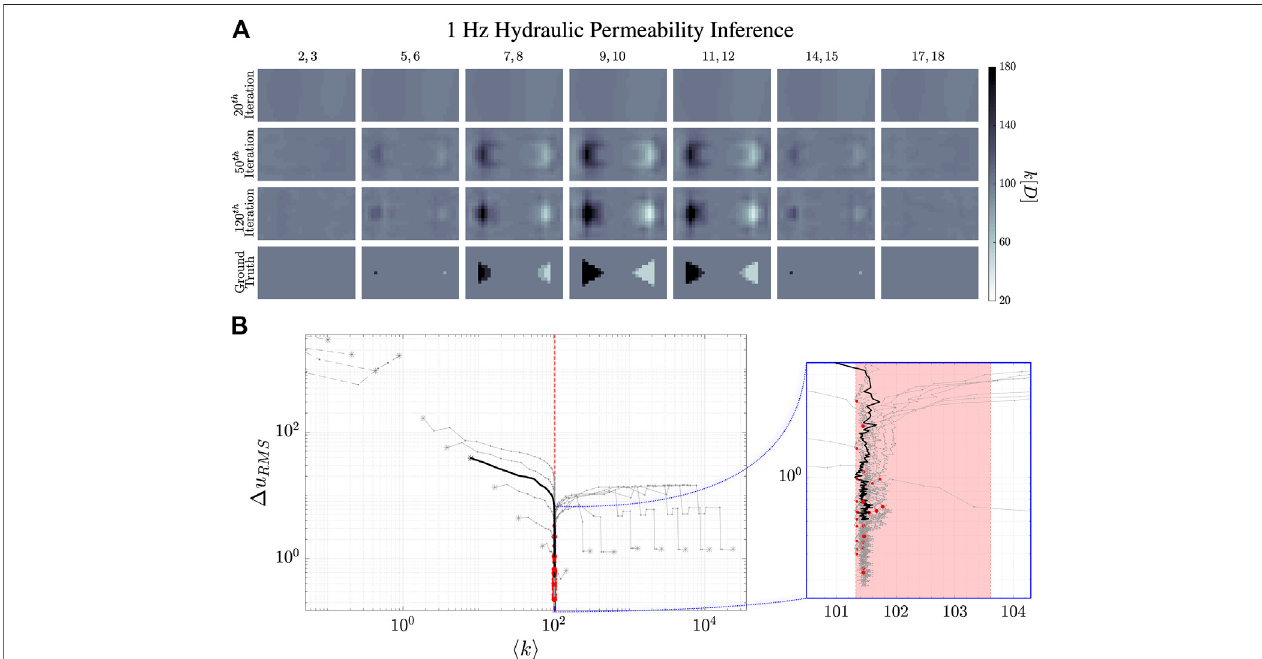
FIGURE 9 | Reconstruction evolution of the hydraulic permeability, k , at 1 Hz. (A) shows the reconstructed images of the hydraulic permeability distribution. The column images are the averages of the numbered ( xy ) -planes (top row). The rows are labeled by the iteration number of the inference. (B) shows the lower dimensional trajectory of the shear modulus. As above, the hydraulic permeability is measured in Darcy. The smaller diagram is a magni fi ed region near the converged values. Initial estimates are noted by an asterisk and changes in descent strategy are indicated by small and large red markers, as explained in the text. The light red region represents the strip between the background value of the shear modulus and the ground truth mean value. The thicker trajectory is the one used to make the images in theabovepanel.Onceagainwewitnessthathydraulicpermeabilityinferenceisrobusttoinitialconditionsovertwoordersofmagnitudeabovethegroundtruth.Withthis simulation we see that the lower bound has gotten better as well, robust out to 2 orders of magnitude below the ground truth.